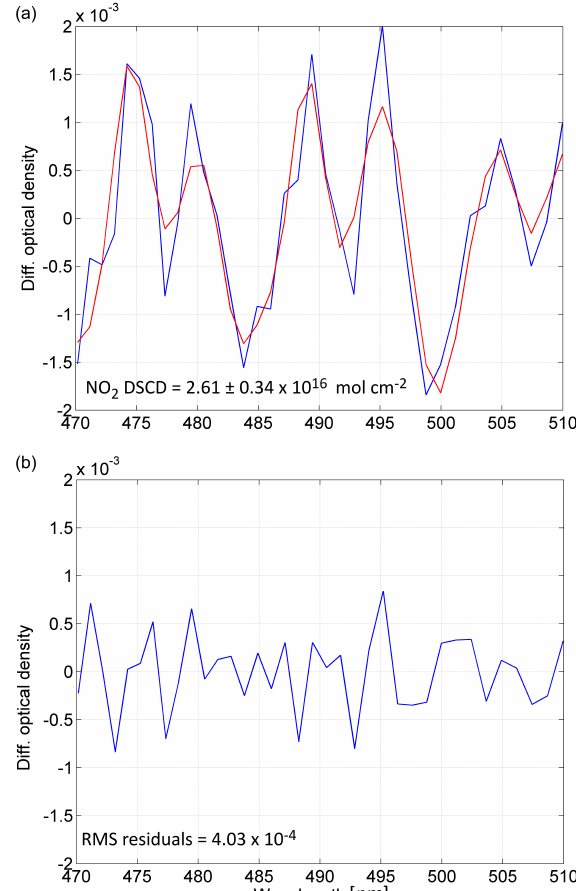
Figure 8. Typical DOAS fit with (a) red line, corresponding to the NO 2 molecular cross section, convolved with the instrument slit function and scaled to the detected absorption in the measured spec- trum (blue line) and (b) the remaining residuals of the spectral